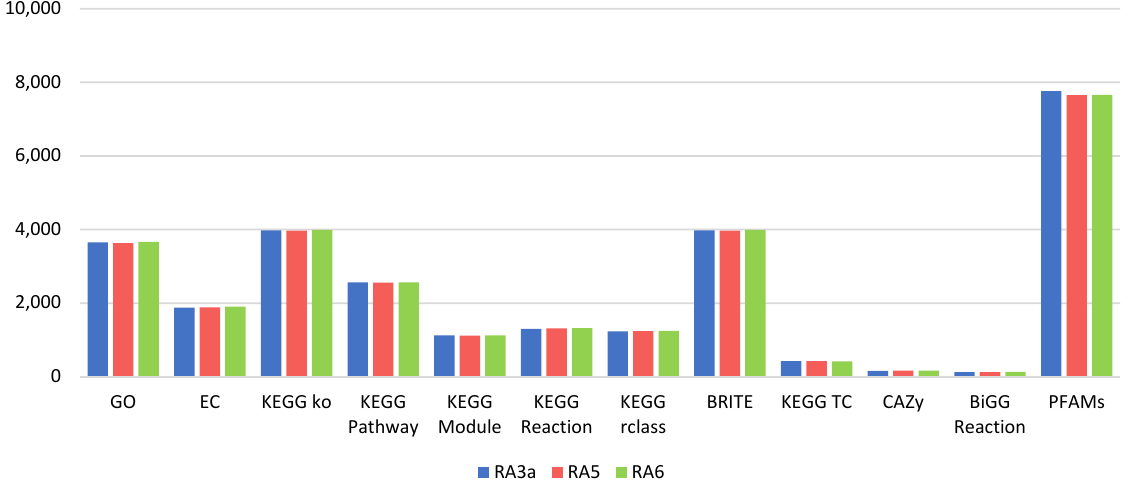
Figure 5. Assignment of predicted proteins in the three fungal isolates RA3a, RA5, and RA6 using eggnog mapper to multiple databases.